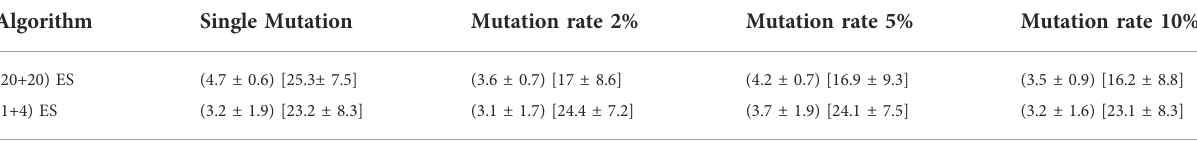
TABLE 1 Performance obtained by introducing a single mutation and by varying the mutation rate. The values included in round brackets show the average and the standard deviation of performance.The values shown in square brackets indicatethe averageand the standard deviation of size. Results obtained with the standard (20+20) and (1+4) algorithms. The experiments performed by using a mutation rate of 10% are the same experiments reported